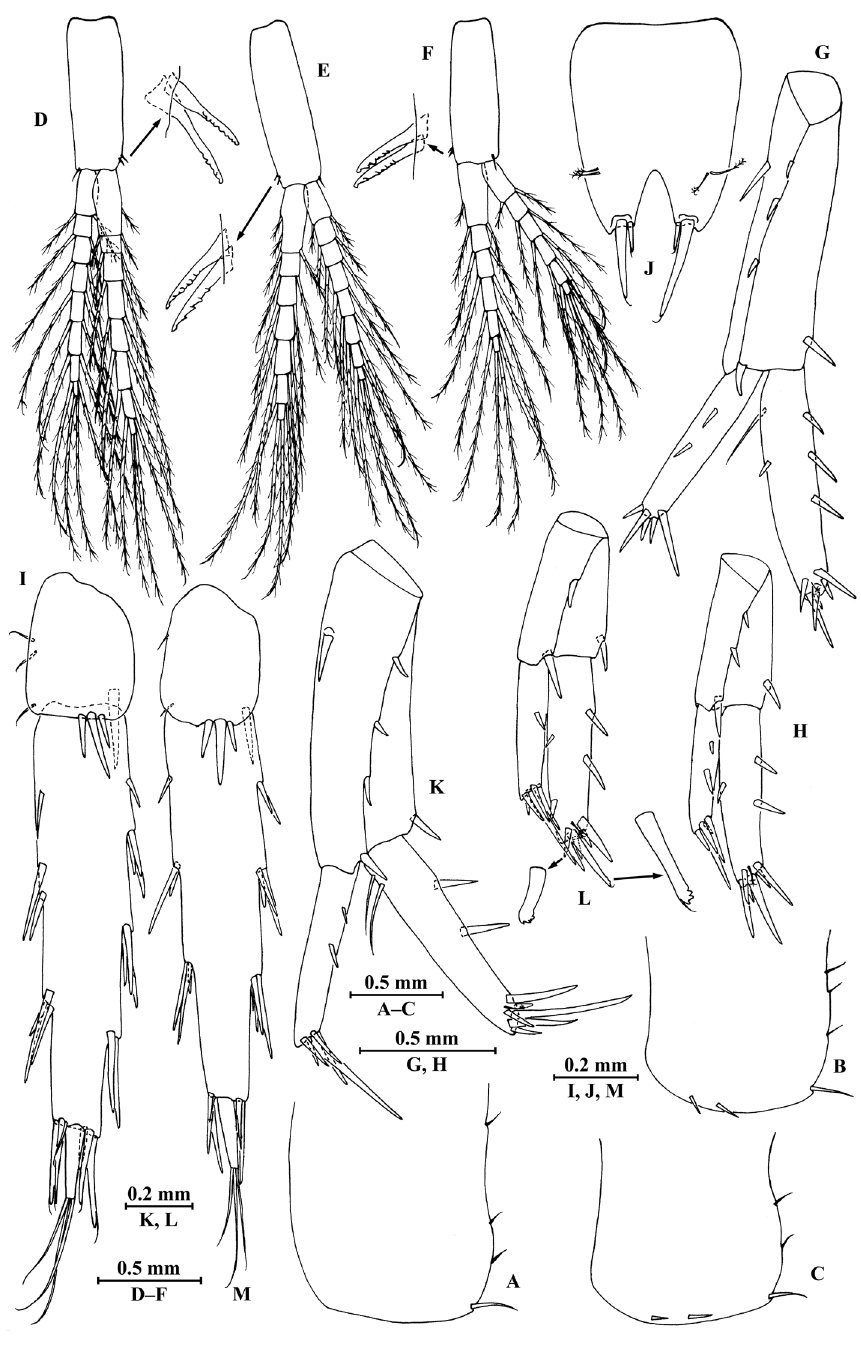
Figure 5. Pseudocrangonyx elegantulus sp. n., A–J female K–M male A epimeral plate I B epimeral plate II C epimeral plate III D pleopod I E pleopod II F pleopod III G uropod I H uropod II I uropod III J telson K uropod I L uropod II M uropod